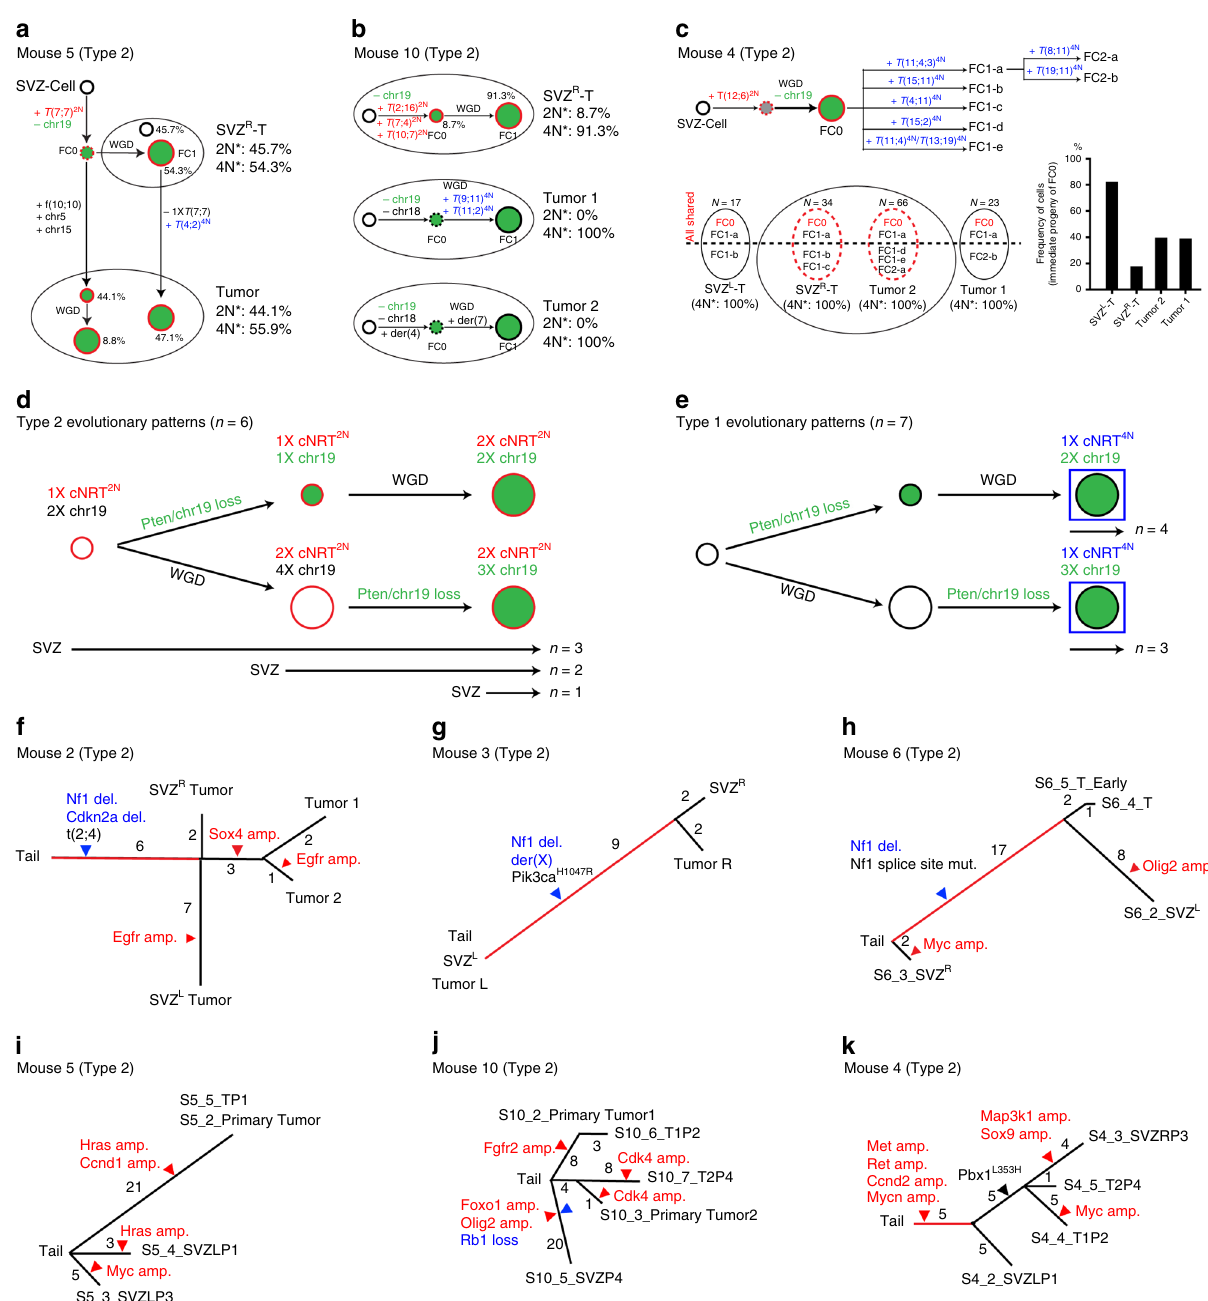
Fig. 6 Distant versus local dispersal from the SVZ to brain parenchyma in additional Type 2 cases. Models show the clonal evolution from the founder cell/clone (FC) to GBMs in three additional Type 2 cases, Mouse 5 ( a ), Mouse 10 ( b ), and Mouse 4 ( c ). Models were constructed using data from SKY- based single-cell analysis. The relative frequency of 2N and 4N cells in each site was shown. Note that the distant dispersal from the SVZ to parenchyma were observed in Mouse 5 ( a ) and Mouse 4 ( c ) based on the genetic complexity of FCs. In Mouse 10 ( b ), local evolution of clonally related near-2N and sub-4N cells carrying three different cNRT 2N s (labeled with red color and superscript “ 2N ” ) in the SVZ tumor was illustrated. In Mouse 4, total metaphases (cells) of SVZ L -T ( n = 17), SVZ R -T ( n = 36), Tumor 1 ( n = 23), and Tumor 2 ( n = 64) were analyzed and the percentage of cells derived from FC0 in each sample was compared ( c ). Summary of tumor evolutionary patterns in all six Type 2 ( d ) and seven Type 1 cases ( e ) was analyzed. The number of cases that match each of these predicted growth patterns are noted below. The trees based on shared and private events in cancer drivers from WGS data were manually reconstructed for all Type 2 cases, Mice 2 ( f ), 3 ( g ), 6 ( h ), 5 ( i ), 10 ( j ), and 4 ( k ). The shared and private events between SVZ- and parenchymal tumor-derived cells were placed on the trunks and branches of each tree, respectively. Shared events determined the phylogenetic order of samples. Length is proportional to the number of events (number indicated). Arrowheads indicate genetic events (red, ampli fi cation; blue, deletion; and black, mutation). The source data underlying ( f – k ) are provided as a Source data fi